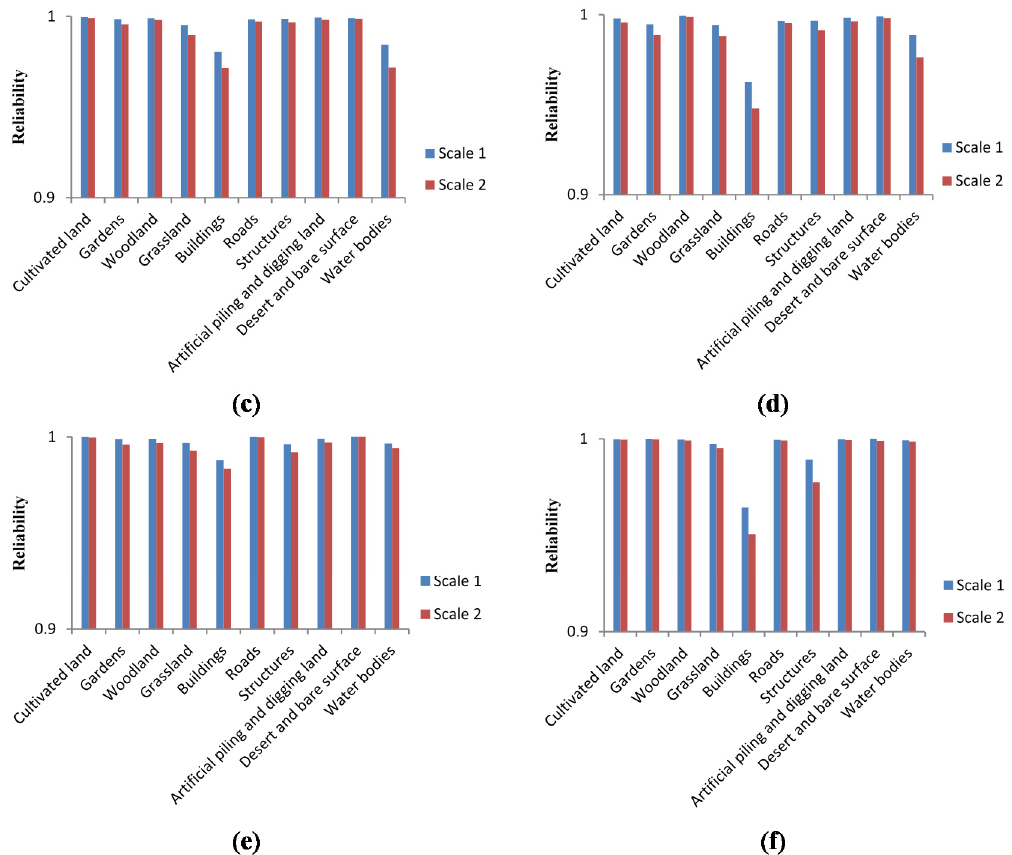
Figure 6. Scale reasonableness of first-level types in the six study areas: ( a ) County 1; ( b ) County 2; ( c ) County 3; ( d ) County 4; ( e ) County 5; and ( f ) County